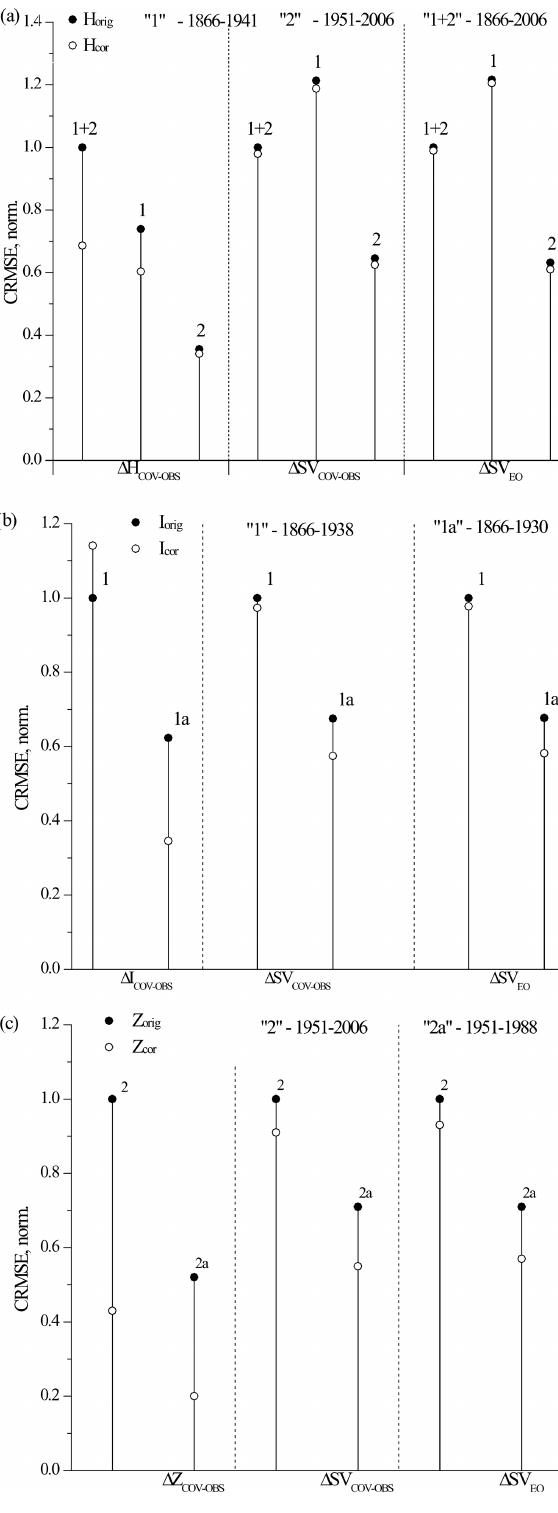
Figure 7. CRMSE of the original (black dots; orig) and corrected (white filled circles; cor) COI series estimated for different time intervals: (a) COI H , (b) COI I and (c) COI Z . CRMSE values are normalized by the standard deviations of the original